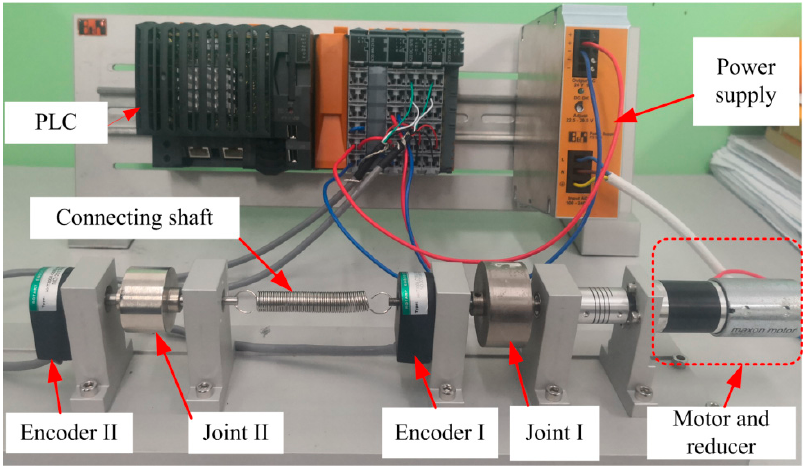
Figure 2. Experimental system of the flexible-joint robot system.